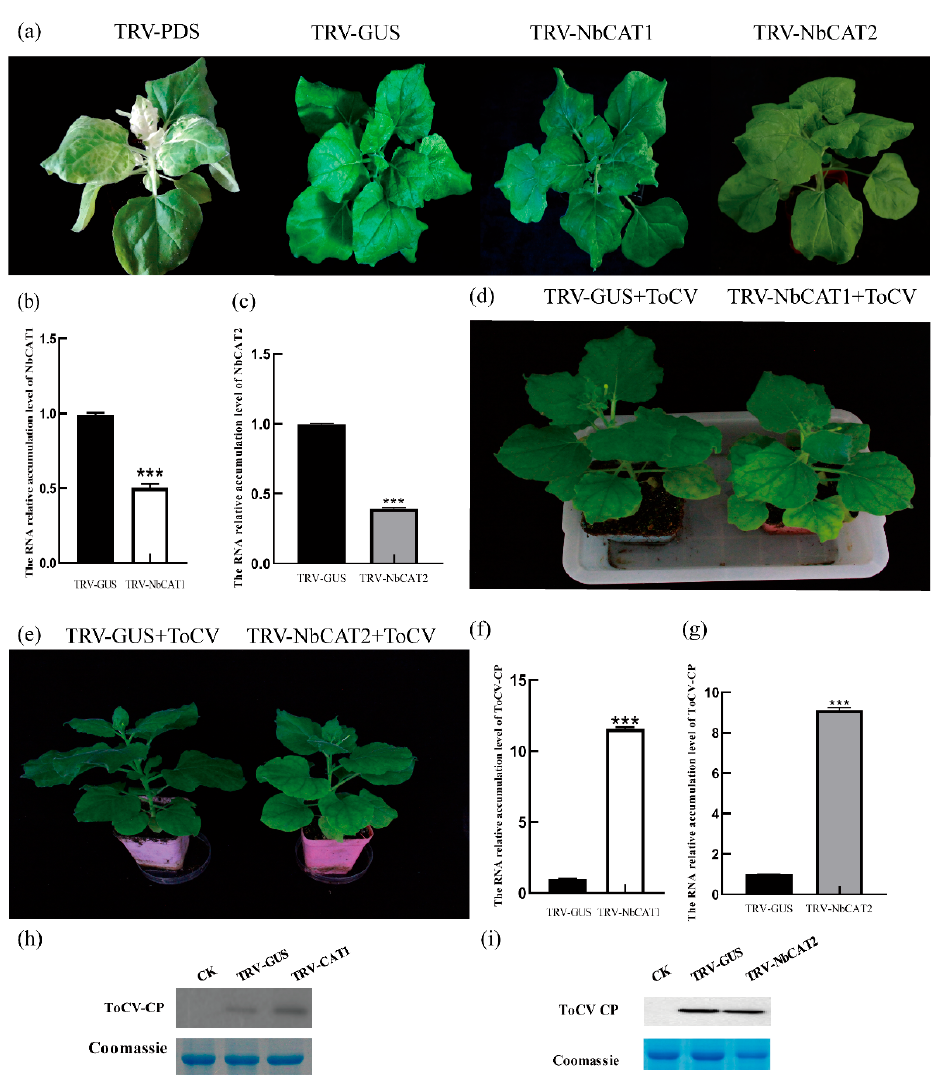
Figure 6. TRV-mediated silencing of the NbCAT1 gene promotes ToCV infection of host plants. ( a ) Phenotype of N. benthamiana with TRV-mediated silencing of the NbCAT1 and NbCAT2 gene. ( b ) Detection of the silencing efficiency of the NbCAT1 gene in N. benthamiana by qRT-PCR at 10 dpi. ( c ) Detection of the silencing efficiency of the NbCAT2 gene in N. benthamiana by qRT-PCR at 10 dpi. ( d ) The ToCV symptom in N. benthamiana silent in NbCAT1. ( e ) The ToCV symptom in N. benthamiana silent of NbCAT2. ( f ) The relative accumulation of ToCV CP in N. benthamiana without NbCAT1 by qRT-PCR. ( g ) The relative accumulation of ToCV CP in N. benthamiana silent of NbCAT2 by qRT-PCR. ( h ) Western blot detection showing the expression of the ToCV CP protein in the upper leaves of N. benthamiana silent of NbCAT1 at 20 dpi. ( i ) Western blot detection showing the expression of the ToCV CP protein in the upper leaves of N. benthamiana silent of NbCAT1 at 20 dpi. Error bars indicate standard deviation and statistical significance was calculated with Student’s t -test (*** p <